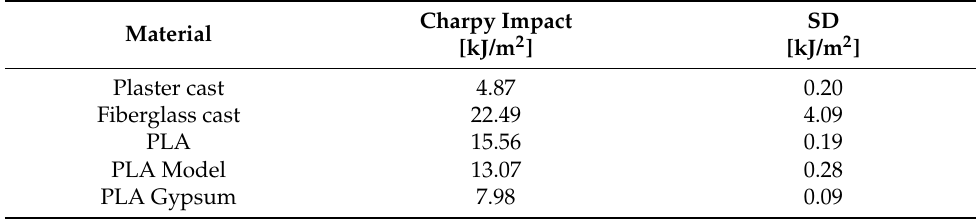
Table 1. The measured Charpy impact strength values.